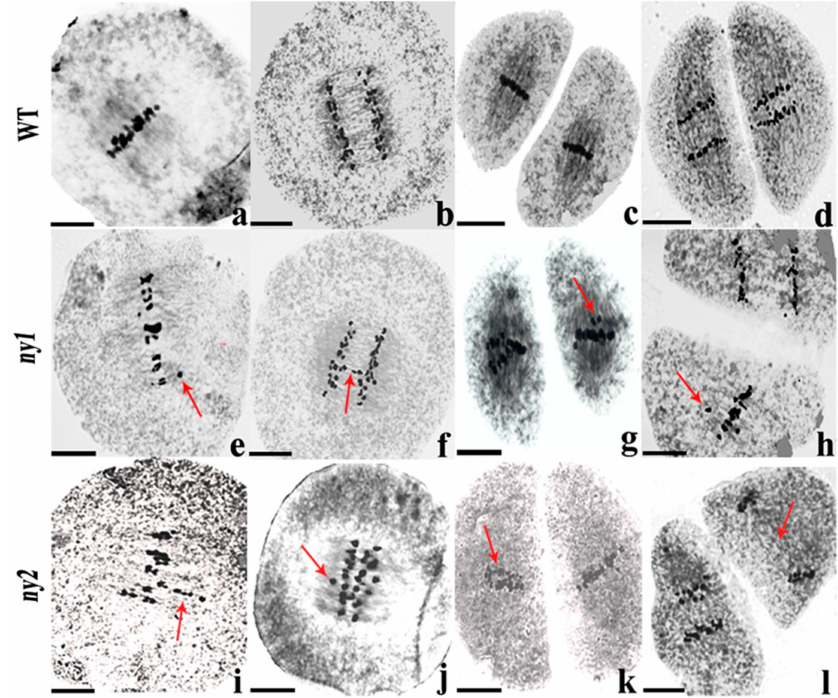
Figure 6. Chromosome behavior of PMC meiosis in wild type (WT), ny1 and ny2 mutant lines. ( a – d ) indicate metaphase I; anaphase I; metaphase II; anaphase II images of wild-type. ( e – h ) are showing metaphase I; anaphase I; metaphase II; anaphase II images of ny1 and ( i – l ) represent metaphase I; anaphase I; metaphase II; anaphase II images of ny2 . Red arrows indicate abnormal chromosomes. Bars = 50 µ